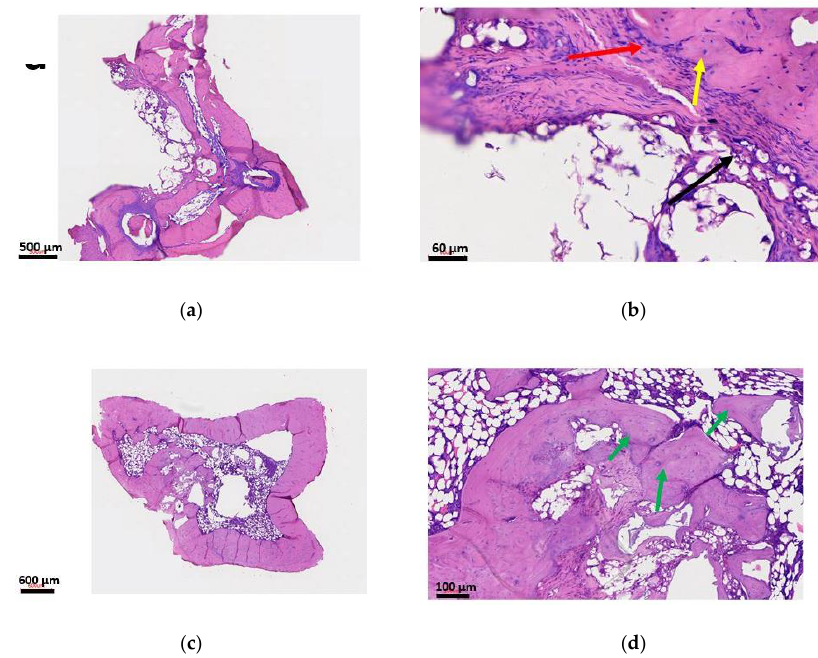
Figure 8. H&E staining of rat tibia. Images ( a , b ) are from the infection control group showing signs of osteomyelitis. Narrowing of the marrow space and destruction of the bone is visible. In image ( b ), the red arrow indicates an inflammatory response, whereas the yellow arrow shows an osteoclast and the black arrow shows fibrosing with granulation. In images ( c , d ), the treatment group shows no signs of osteomyelitis. The bone seems to be healing and the implanted ABVF was degraded. The new bone grew into the space that was occupied by ABVF. The green arrow in image ( d ) is showing new bone